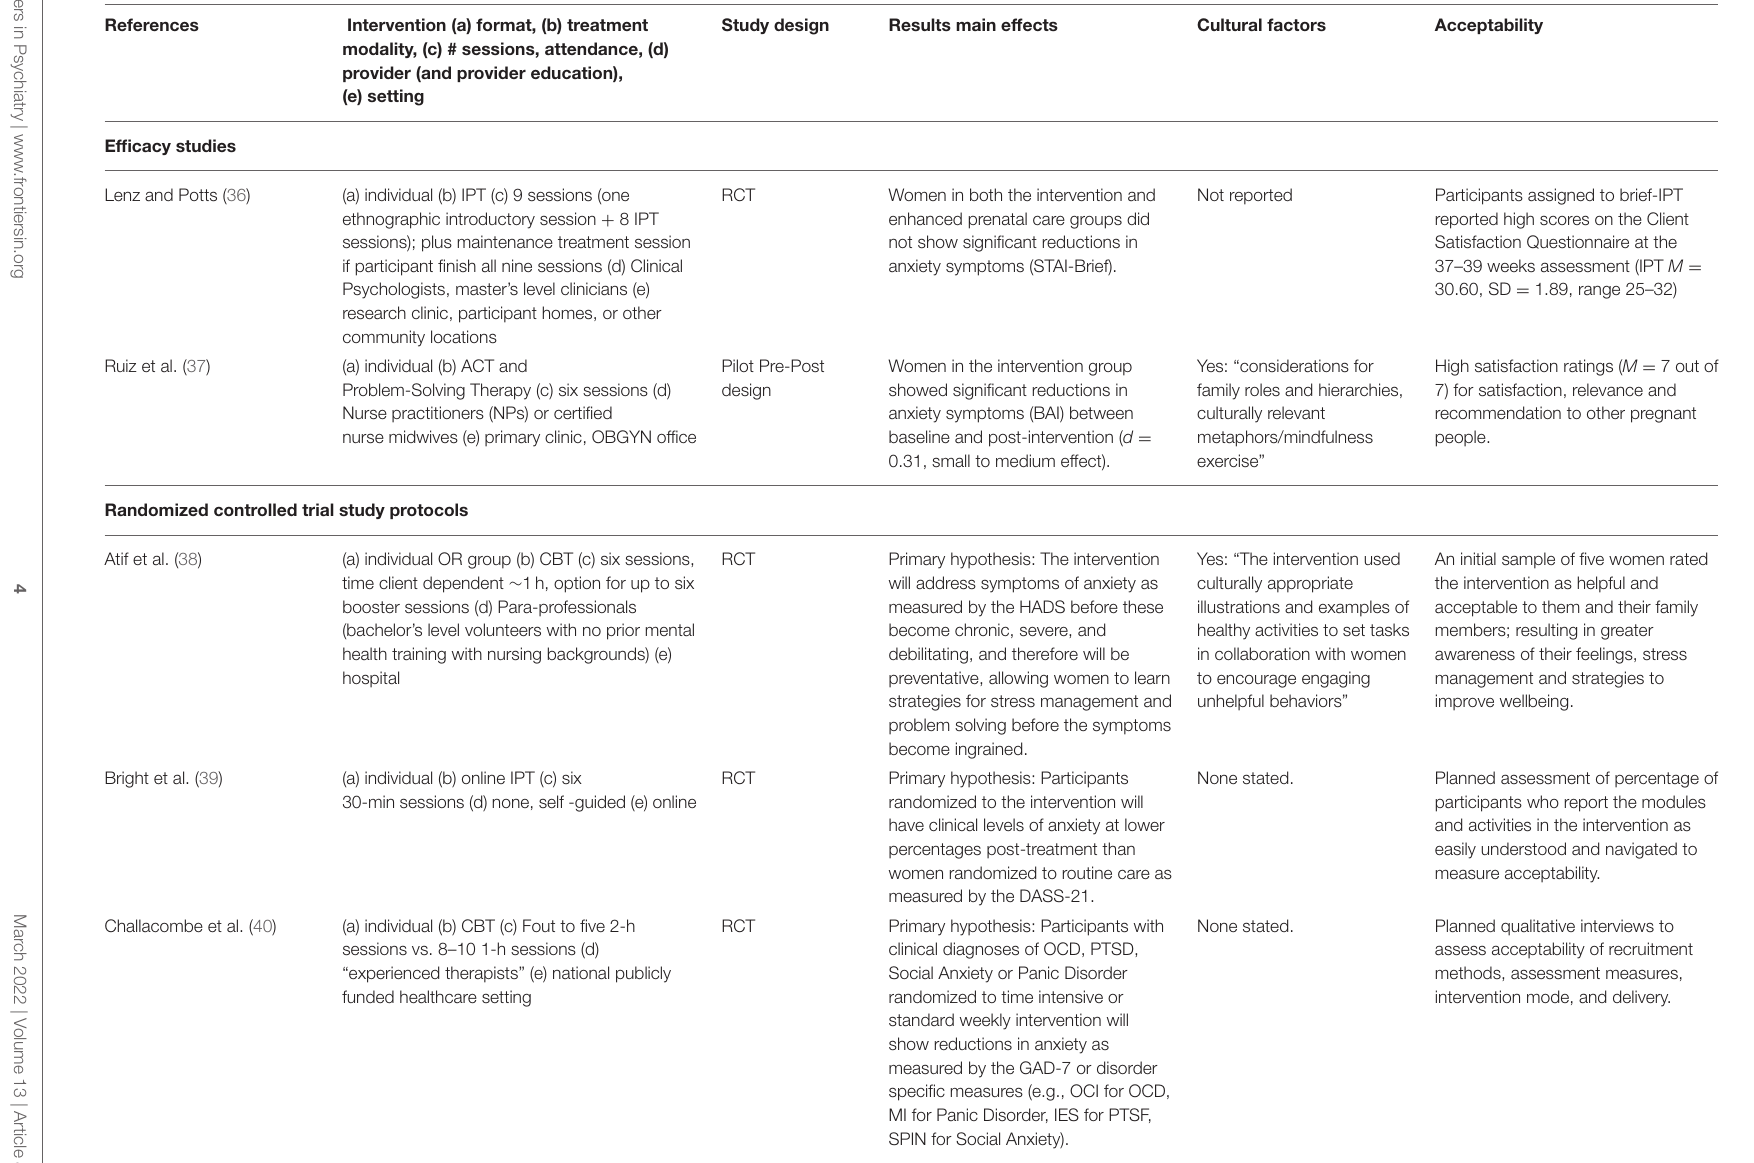
TABLE 1 | Design, measurement, hypotheses and results of reviewed